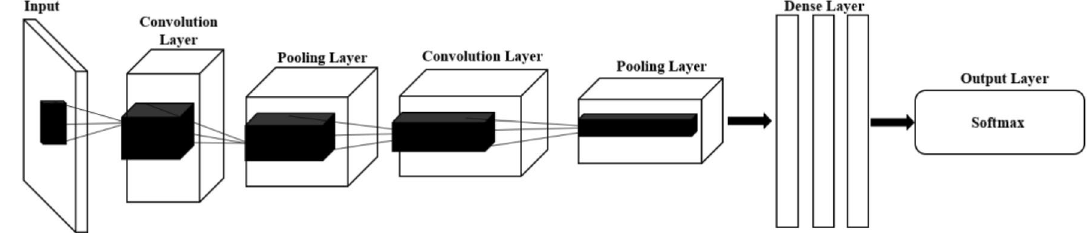
Fig. 2 Diagram of convolutional neural